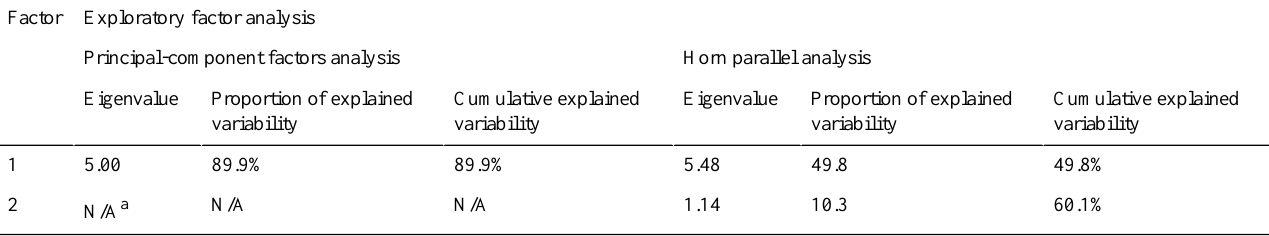
Table 2. Descriptive and goodness-of-fit dimensionality indices from the exploratory factor analysis of the 11 EPICOVID19 symptoms reported by 2703 subjects, based on the principal-component factors and Horn parallel analysis methods with an eigenvalue of >1. Exploratory factor analysisFactor